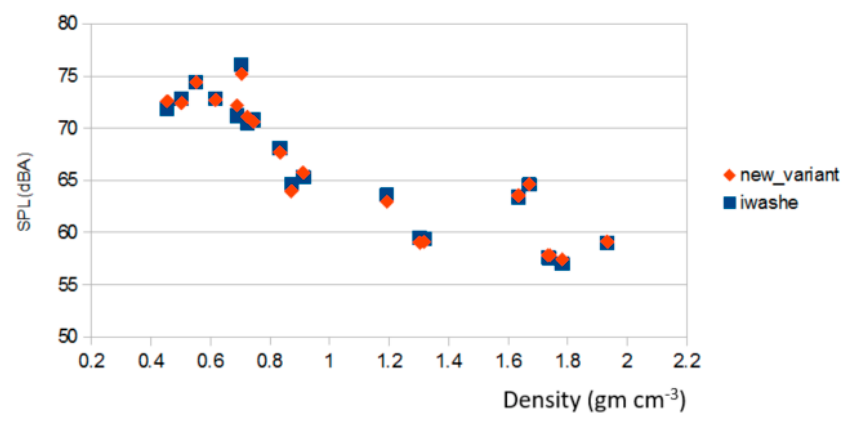
Figure 11. Shown above is a comparison graph for the Iwase [14] method versus the new proposed simplified SSMM method (after correction for bias and slope offset). The comparison utilizes the A-weighted spectral reduction metric to provide a single-valued comparison, from multi-frequency spectral data.